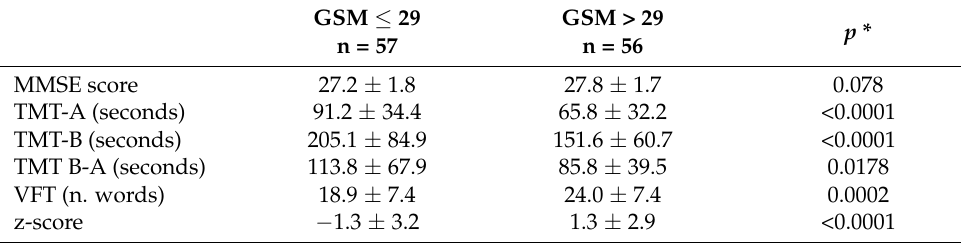
Table 3. Neuropsychological test scores in relation to the median GSM value at